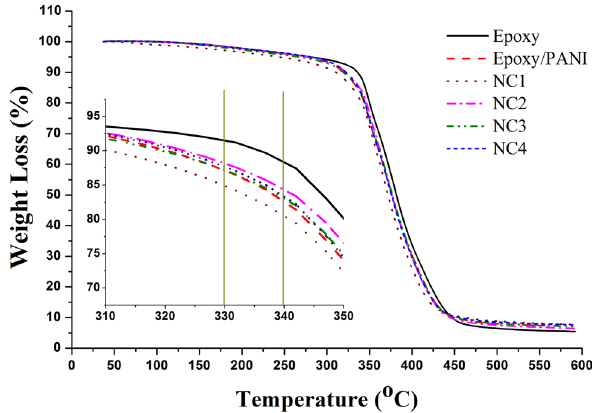
Figure 5: TGA thermograms of epoxy, epoxy/PANI, and epoxy/PANI/ GNPs nanocomposites.